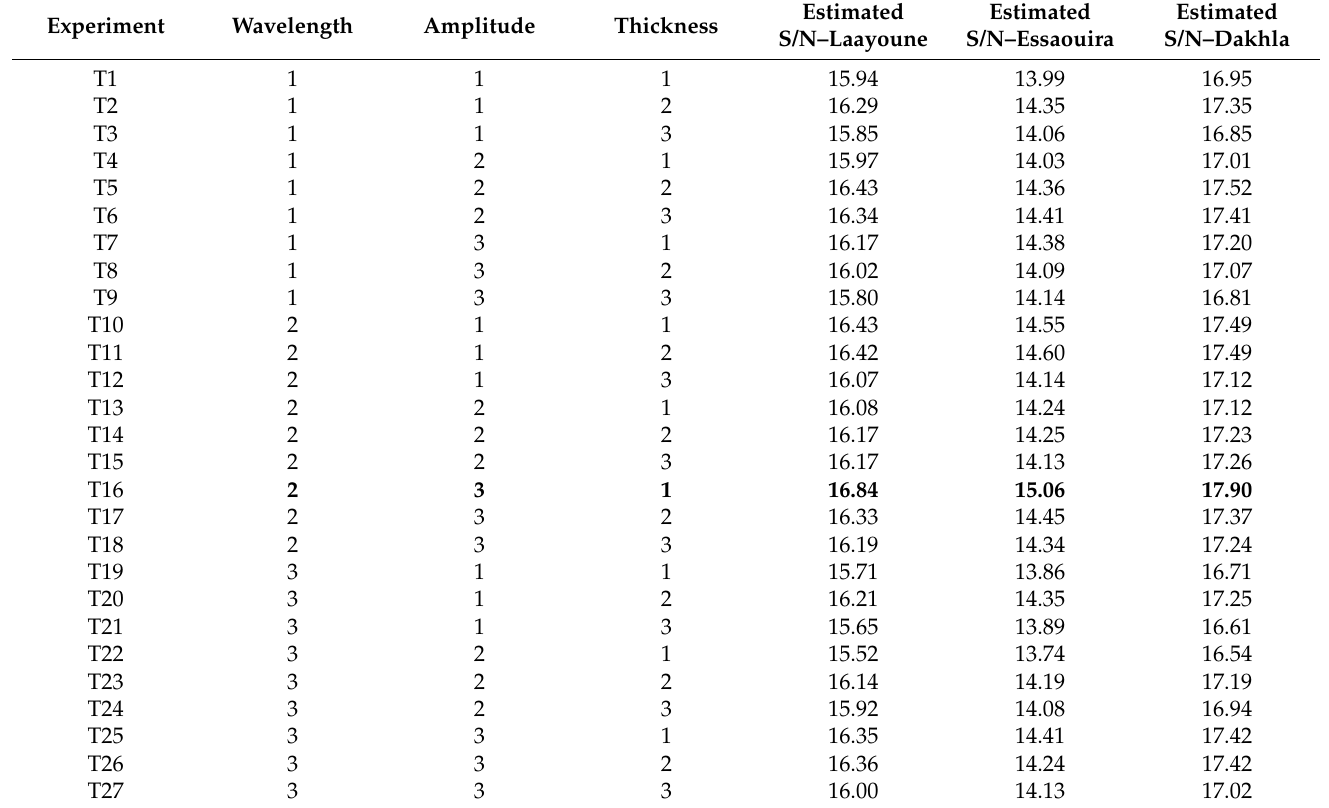
Table A2. Estimated SN ratios using the modified additive